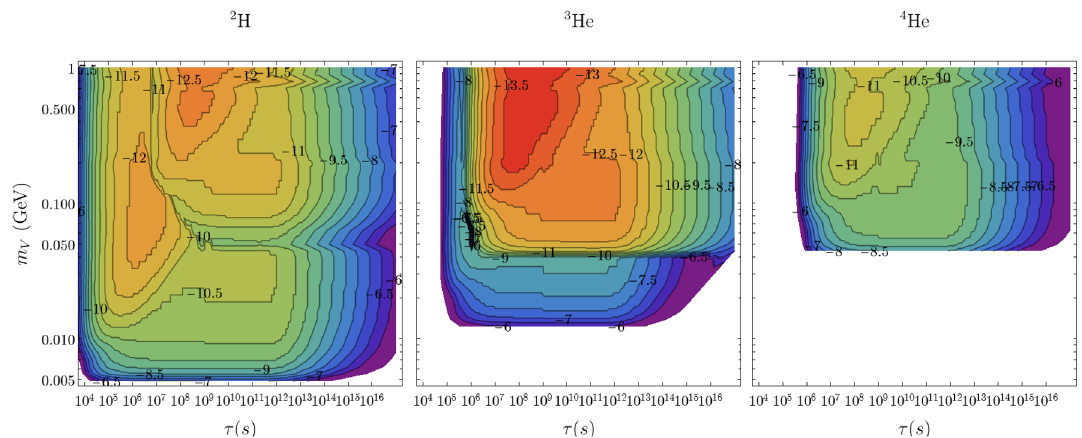
Figure 4 . BBN photodisintegration constraints on mass times abundance of dark photons from measurements of primordial abundances of 2 H , 3 He, and 4 He quoted in Eq. (4.6). The contours represent the upper bounds in log ( m GeV ) V Y V / 10